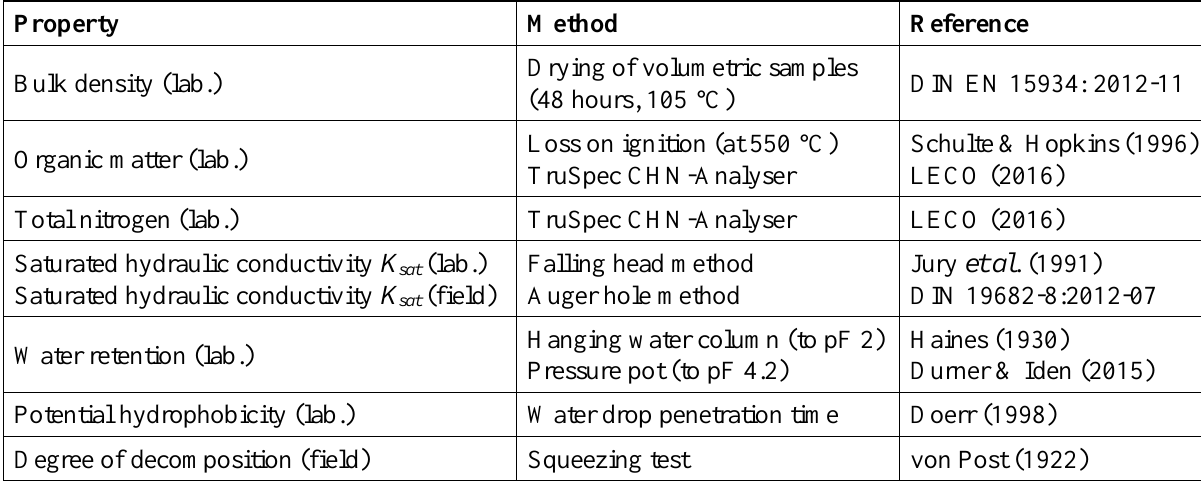
Table 3. The laboratory and field methods used: (lab.) = determined in laboratory; (field) = determined in field.